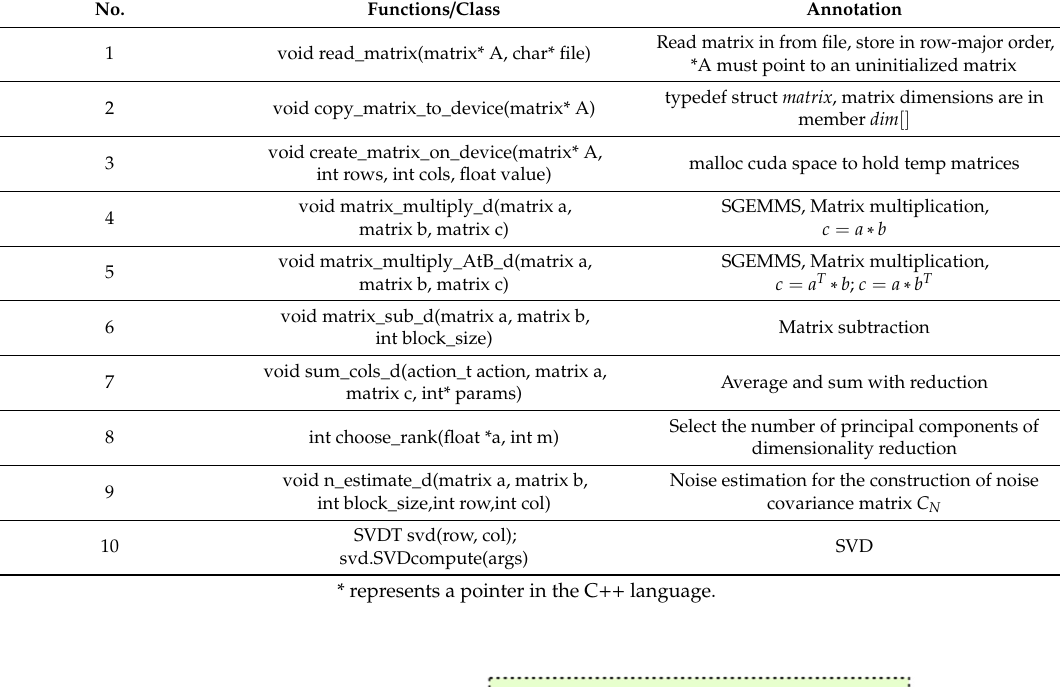
Table 1. Key functions or class and their relative annotation.